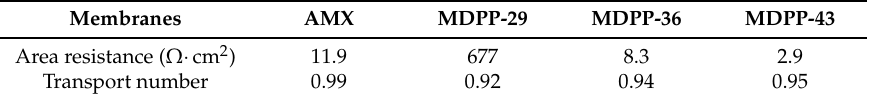
Table 3. Area resistance and transport number of membrane MDPP-29 to